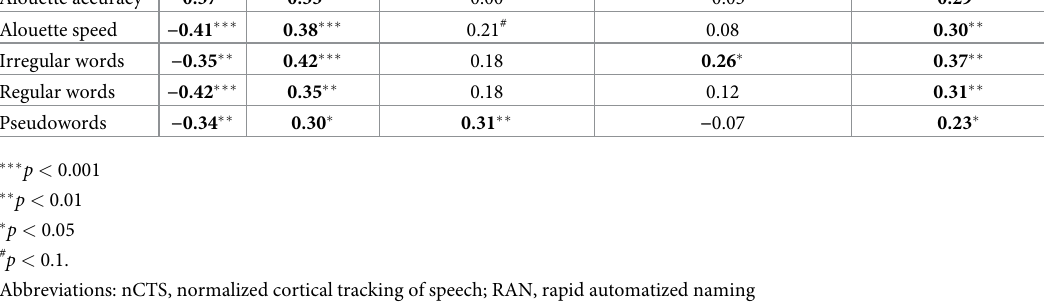
Table 4. Pearson correlation between measures of reading abilities and relevant brain and behavioral measures. Reading